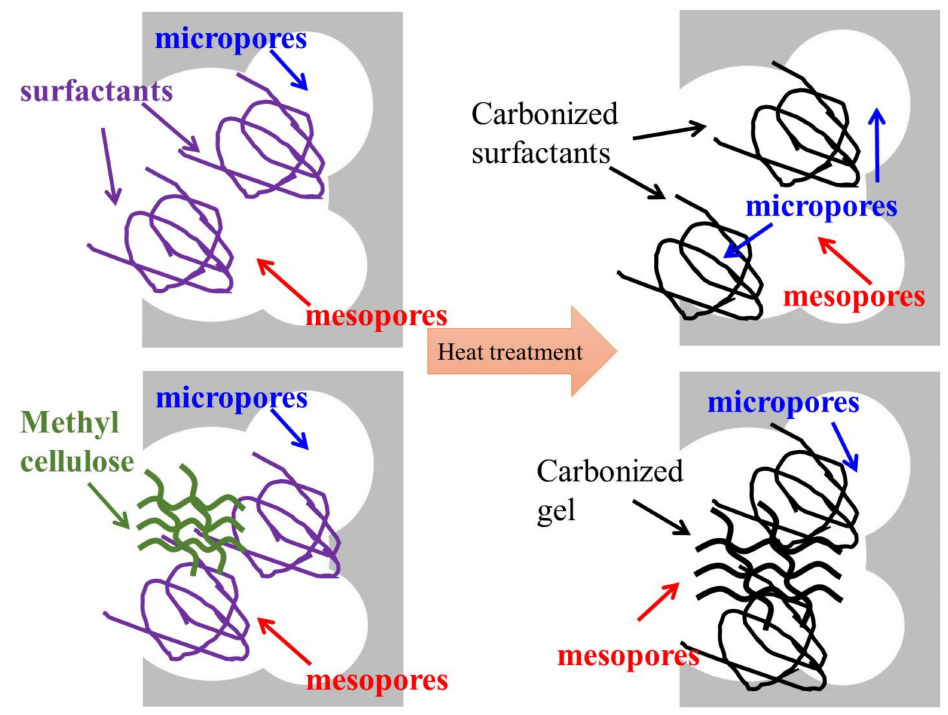
Figure 1. Illustration of upgrading through microstructure manipulation by the carbonization of carbon precursors in pores of waste